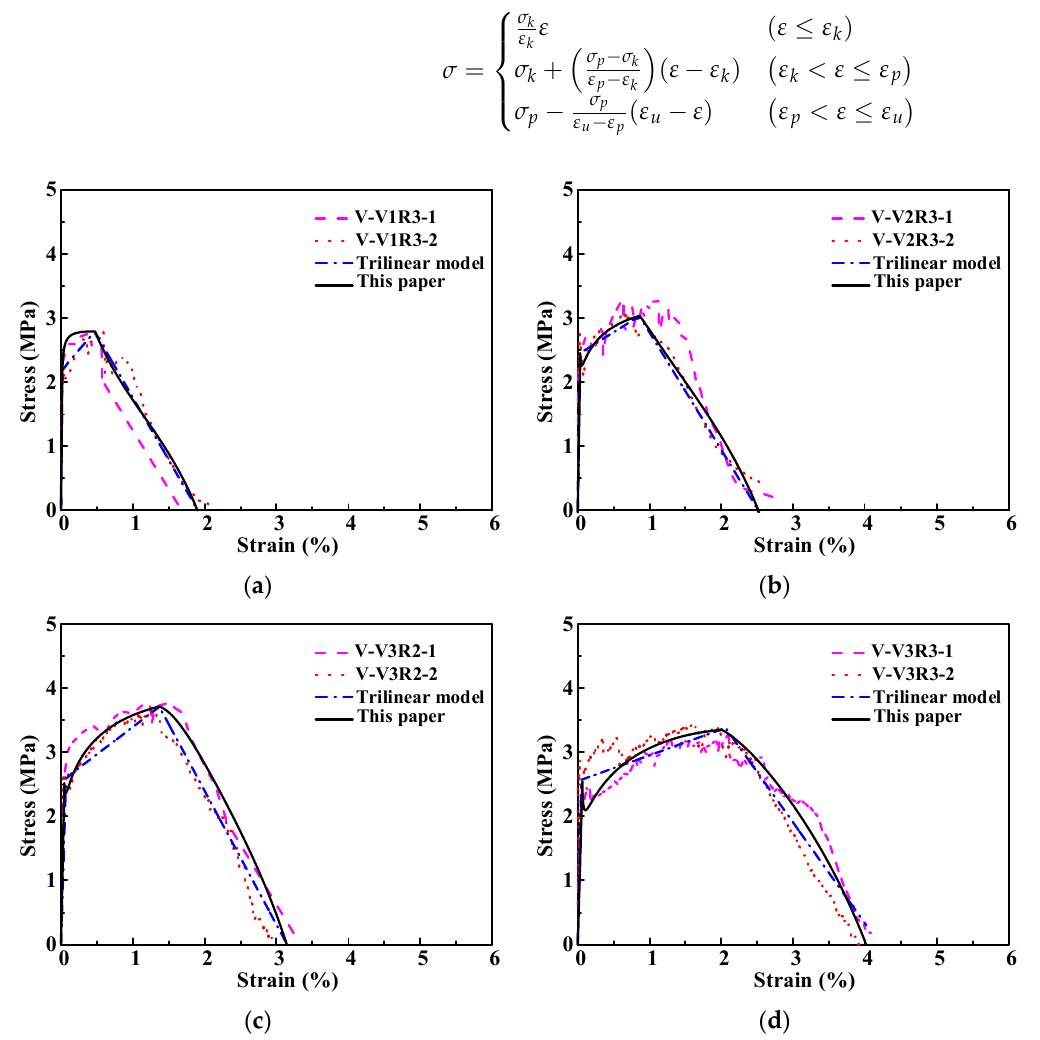
Figure 6. Tensile stress strain curves of: ( a ) Group V-V1R3; ( b ) Group V-V2R3; ( c ) Group V-V3R2; ( d ) Group V-V3R3.